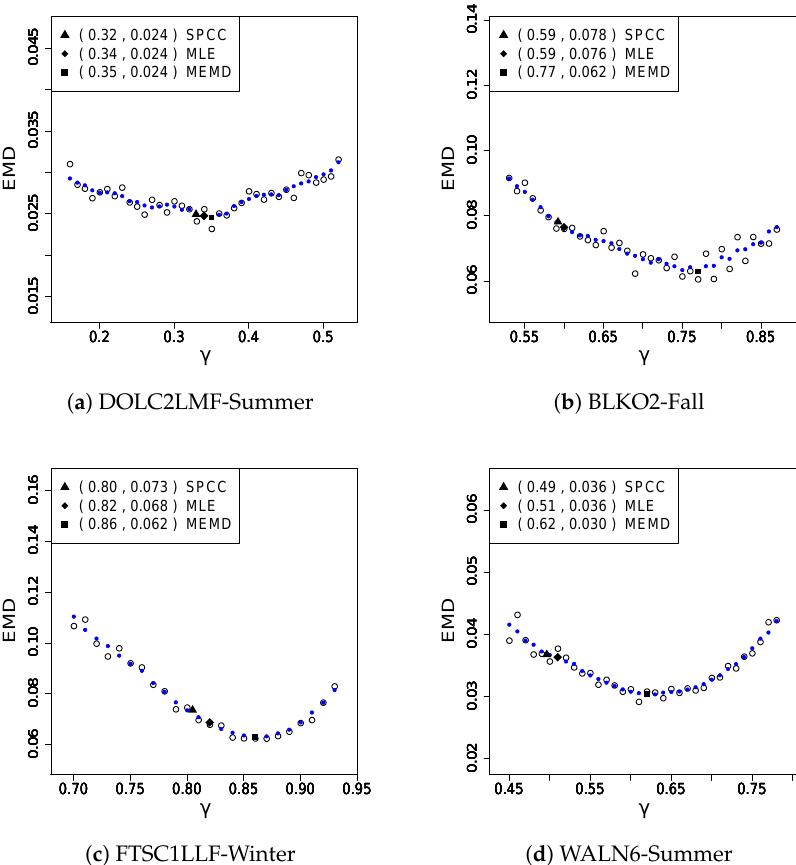
Figure 2. EMD values for the methods of SPCC, MLE, and